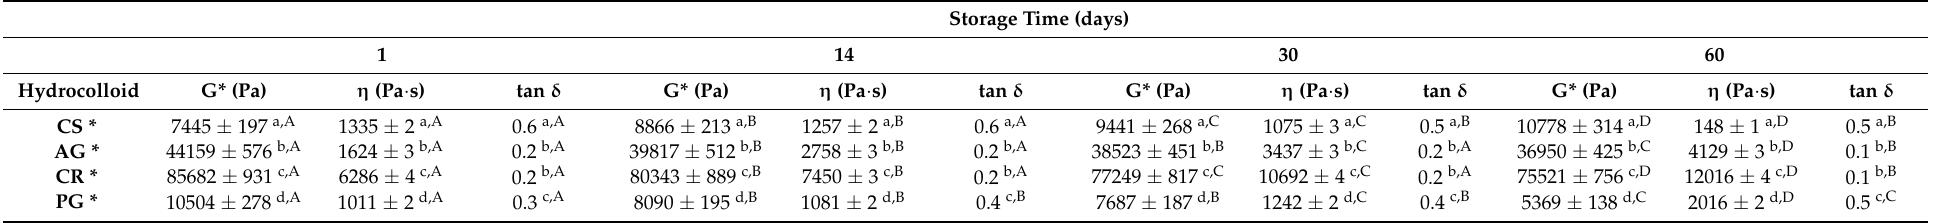
Table 2. Values of the complex modulus of elasticity, complex viscosity, and loss tangent of the model processed cheese samples during a storage time of 60 days (at 6 ± 2 ◦